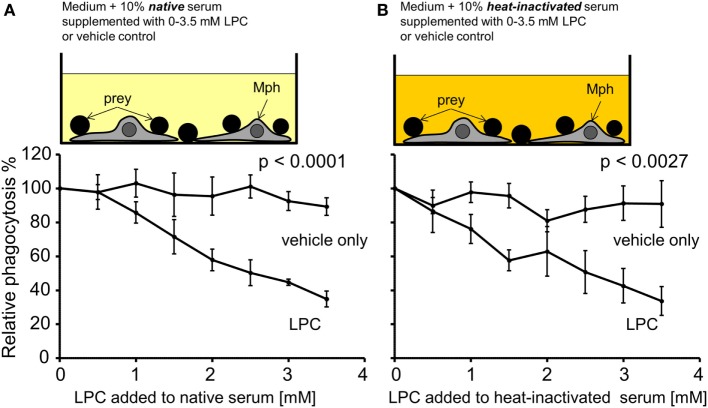
Exogenously added lysophosphatidylcholine (LPC) reduces phagocytosis of necrotic cells in vitro. Normal healthy donor serum was supplemented with the indicated concentrations of purified LPC, added to phagocytosis assays with necrotic cells in its native or heat-inactivated form, and phagocytosis was measured as % of unsupplemented serum (100% control). (A) Data for native serum. (B) Data for heat-inactivated serum. The addition of LPC resulted in a significant concentration-dependent decline in phagocytosis in comparison to the LPC-free control (two-way ANOVA test). Means ± SEs of triplicates are shown.